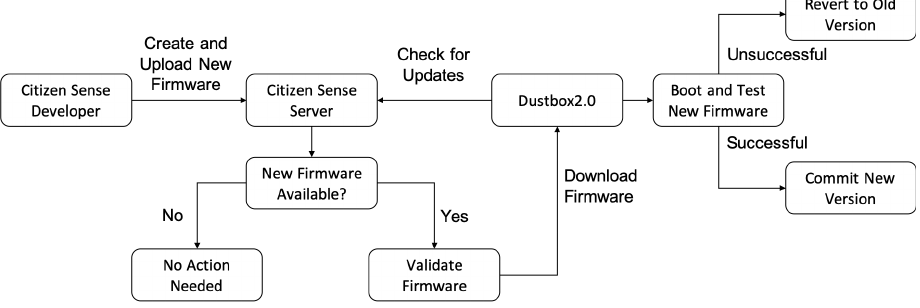
Figure 7. Dustbox 2.0 OTA firmware update flowchart.